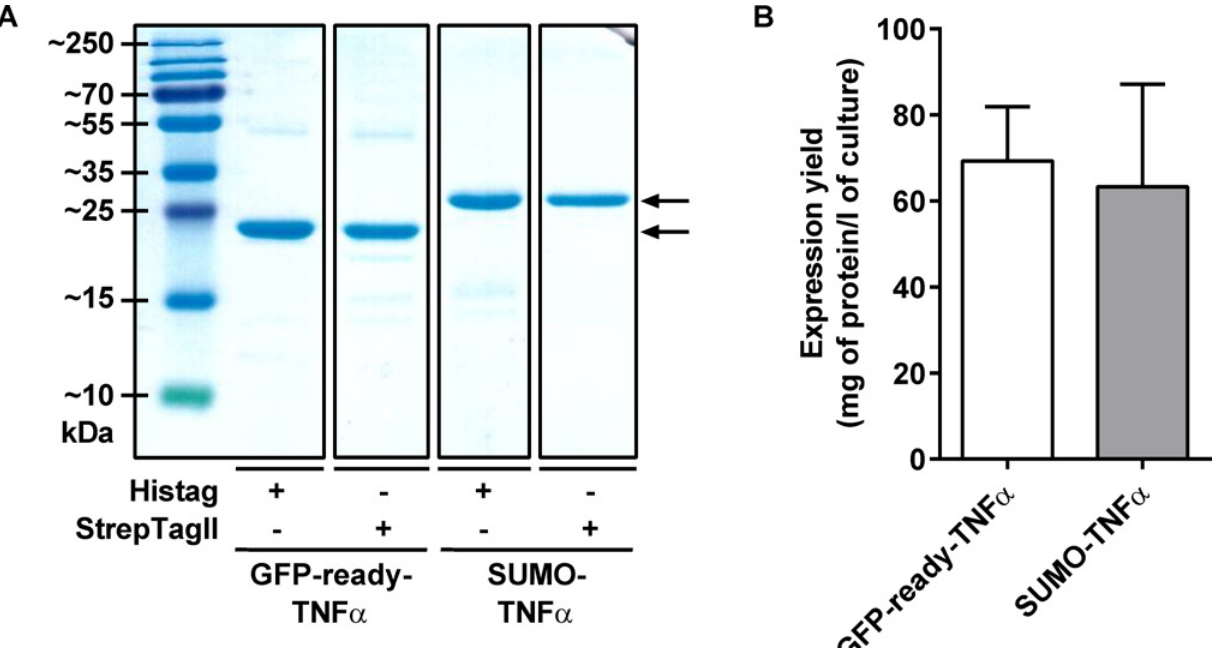
Fig 5. Expression of soluble TNF α recombinant proteins in E . coli . (A) SDS-PAGE profiles with 2 μ g of purified TNF α fusions, after Coomassie blue staining. Bands indicated with an arrow correspond to the expected recombinant proteins. From left to right: Histag GFP-ready-TNF α (MW: 26.5 kDa), StrepTagII GFP-ready-TNF α (MW: 26.6 kDa), Histag SUMO-TNF α (MW: 30.0 kDa), StrepTagII SUMO-TNF α (MW: 30.1 kDa). (B) Expression yields of Histagged GFP-ready-TNF α and SUMO-TNF α . Quantitation performed by biolayer interferometry with Ni-NTA sensors (n = 4).